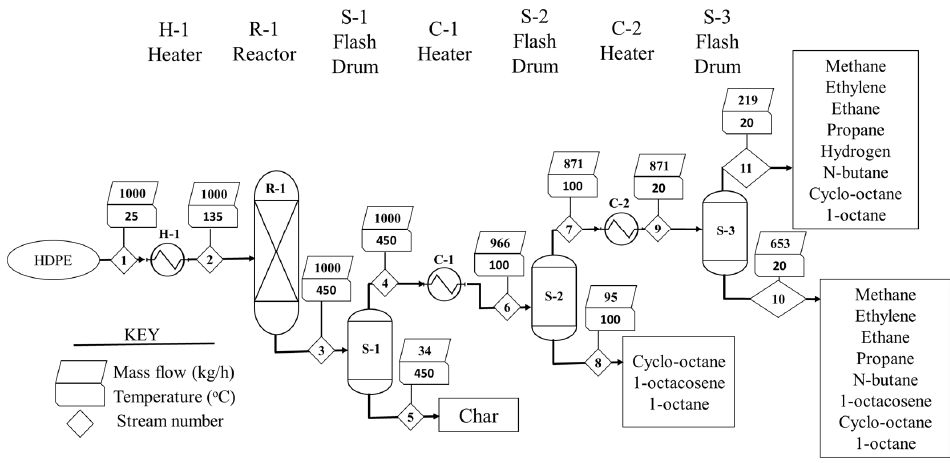
Figure 3. Process flow diagram and stream data for the pyrolysis process. Table 1. Stream data for pyrolysis process.